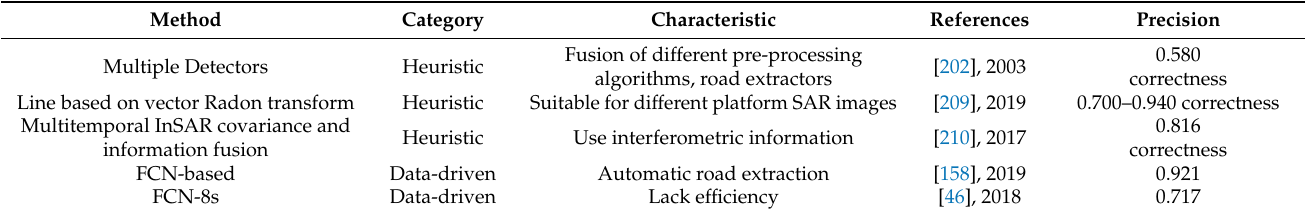
Table 6. Summary of road extraction using SAR